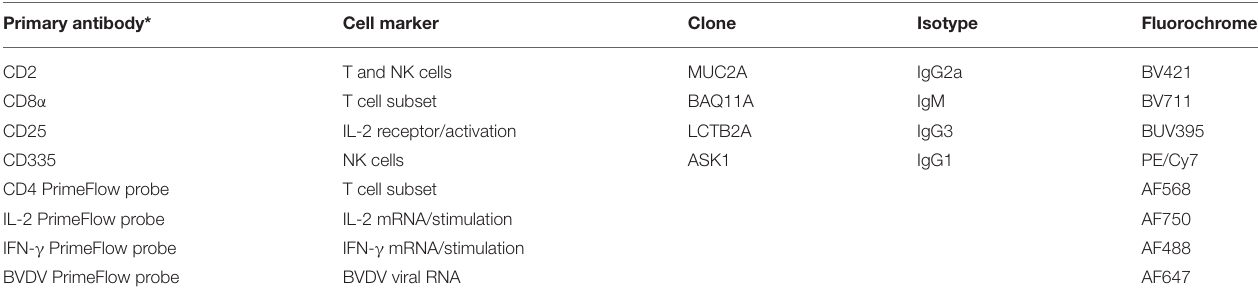
TABLE 1 | Primary and secondary antibodies used for surface marker expression on PBMC’s and Primeflow probes used for cell mediated immune response comparisons. Primary antibody*